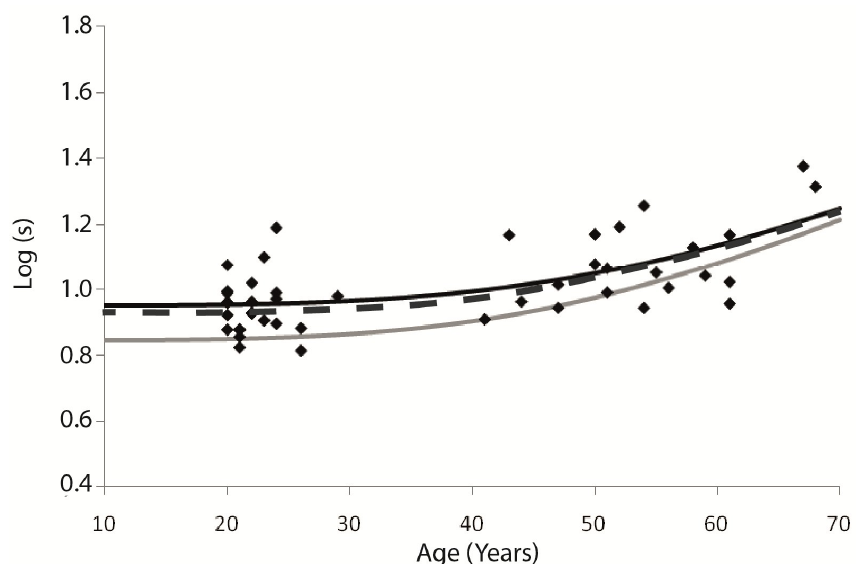
Figure 5. Straylight values after combining the same subject’s measurements at one point. Each point indicates straylight value combining the left and right eyes from one subject. The dark line indicates the function adjusted to these data. The grey line corresponds to the European norms presented in C-Quant. The dark-grey dashed line indicates the new European data obtained by van den Berg in 2013, which corrected the straylight value closer to our model.